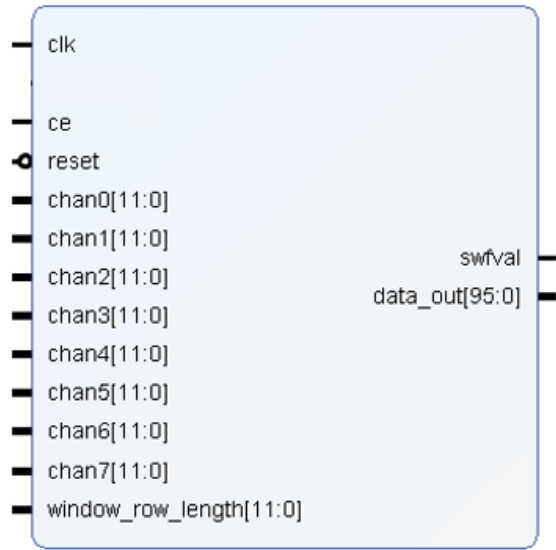
Figure 7. Interface of the implemented swapping.vhd module. Table 3. Port description of the swapping